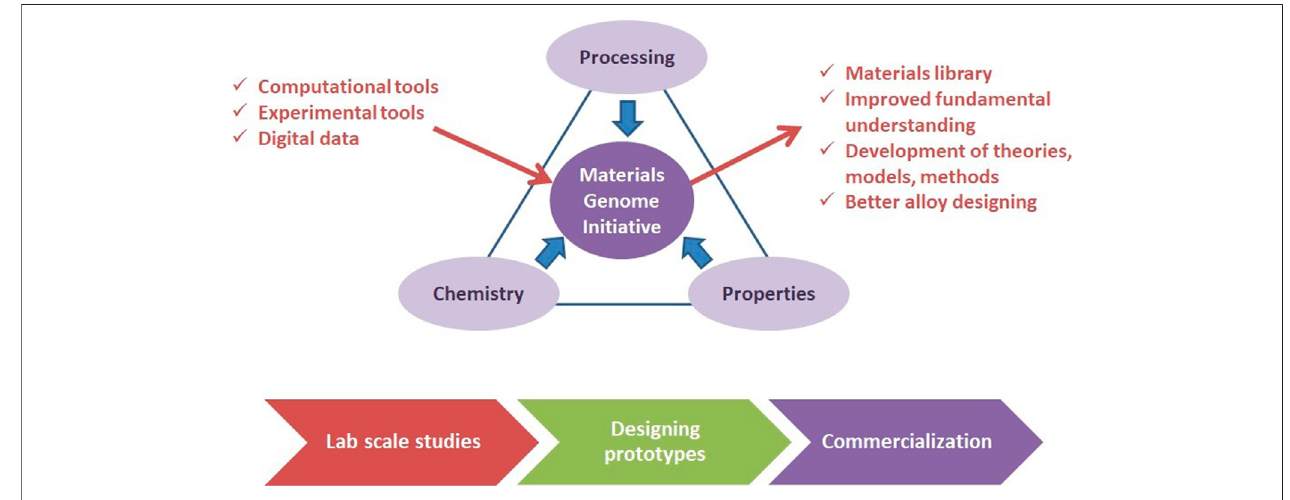
FIGURE 4 | Schematic of a high-throughput alloy design and development